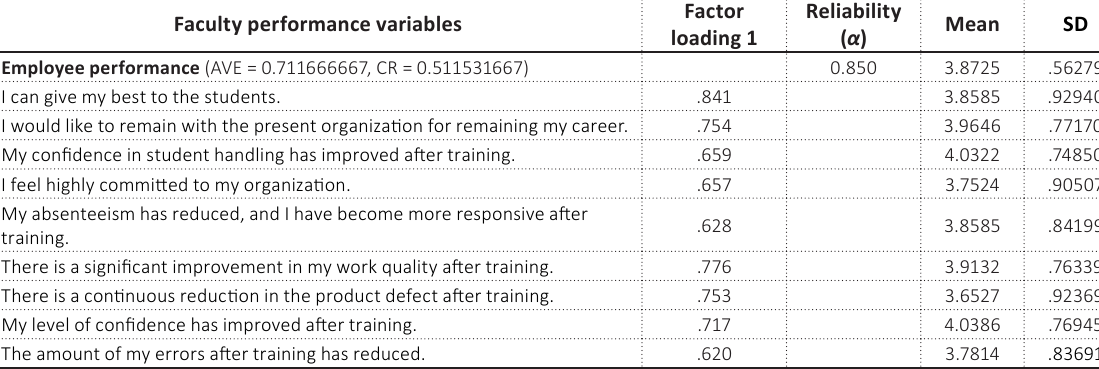
Table 5. Employee performance: Descriptive statistics Faculty performance